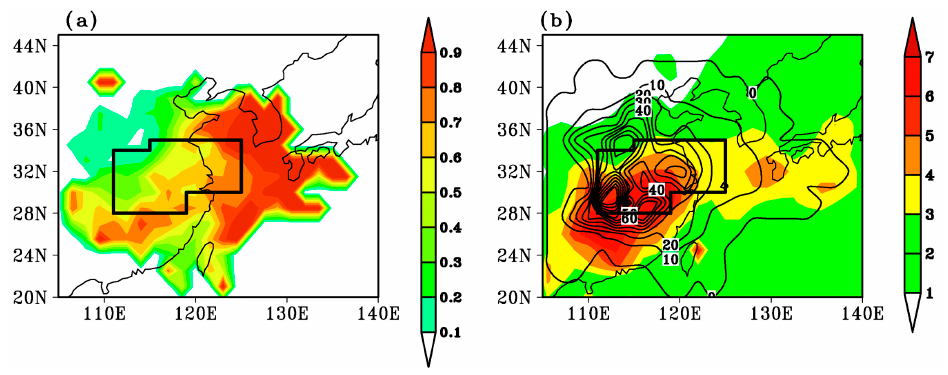
Figure 8. Spatial distribution of short-lived ICs (<18 h). ( a ) Precipitation probability during the lifetime of ICs, ( b ) frequency (the contour line) and accompanied average precipitation (shaded, mm/day).